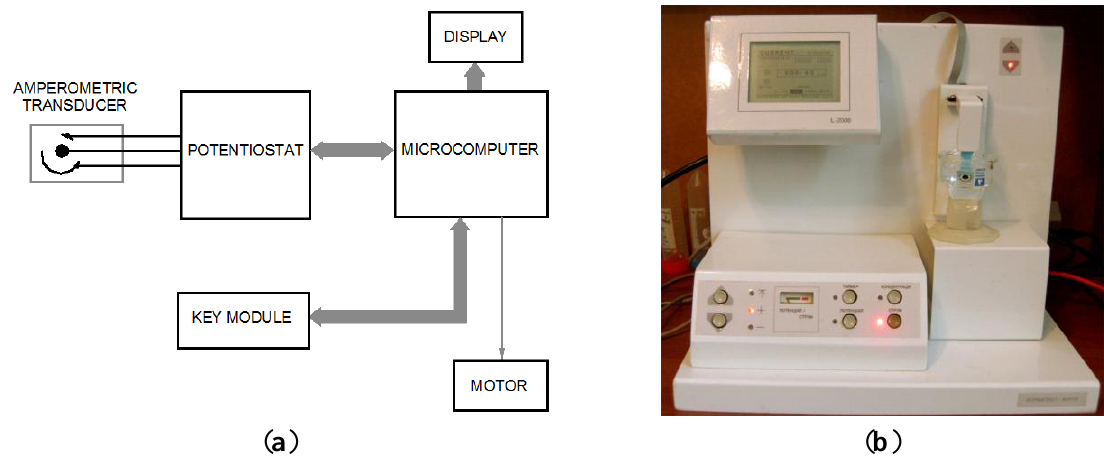
Figure 1. ( a ) Block diagram of the MC; and ( b ) Photograph of the chemosensor-based